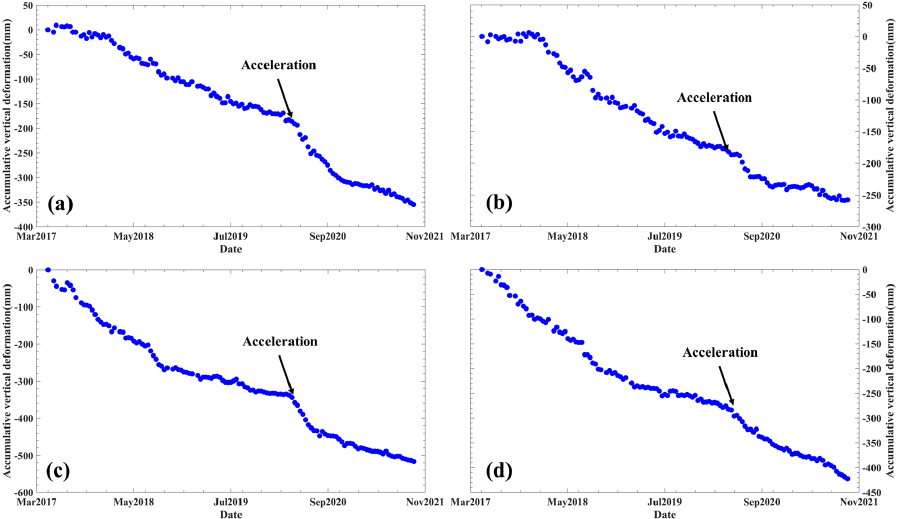
Figure 13. The vertical deformation rate maps and optical remote sensing images of regions A and B in Figure 2c. Remote sensing image acquired on ( a ) 18 June 2019; ( b ) 26 July 2019; ( e ) 30 April 2020; and ( f ) 26 October 2020. ( c , d ) are annual vertical deformation rate maps.